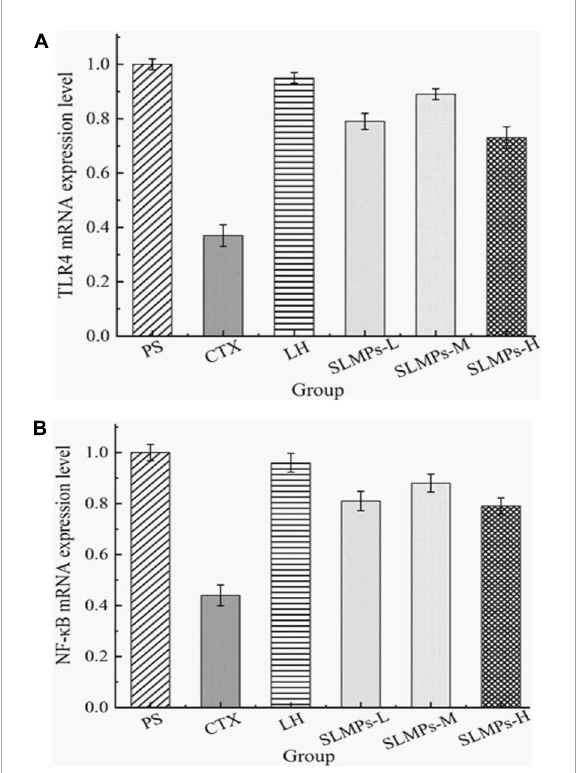
FIGURE10 Effect of SLMPs-1-1 on the regulation of TLR4 and NF- κ B gene expression in mouse tissues. (A) TLR4 gene expression in mouse tissues, (B) NF- κ B gene expression in mouse